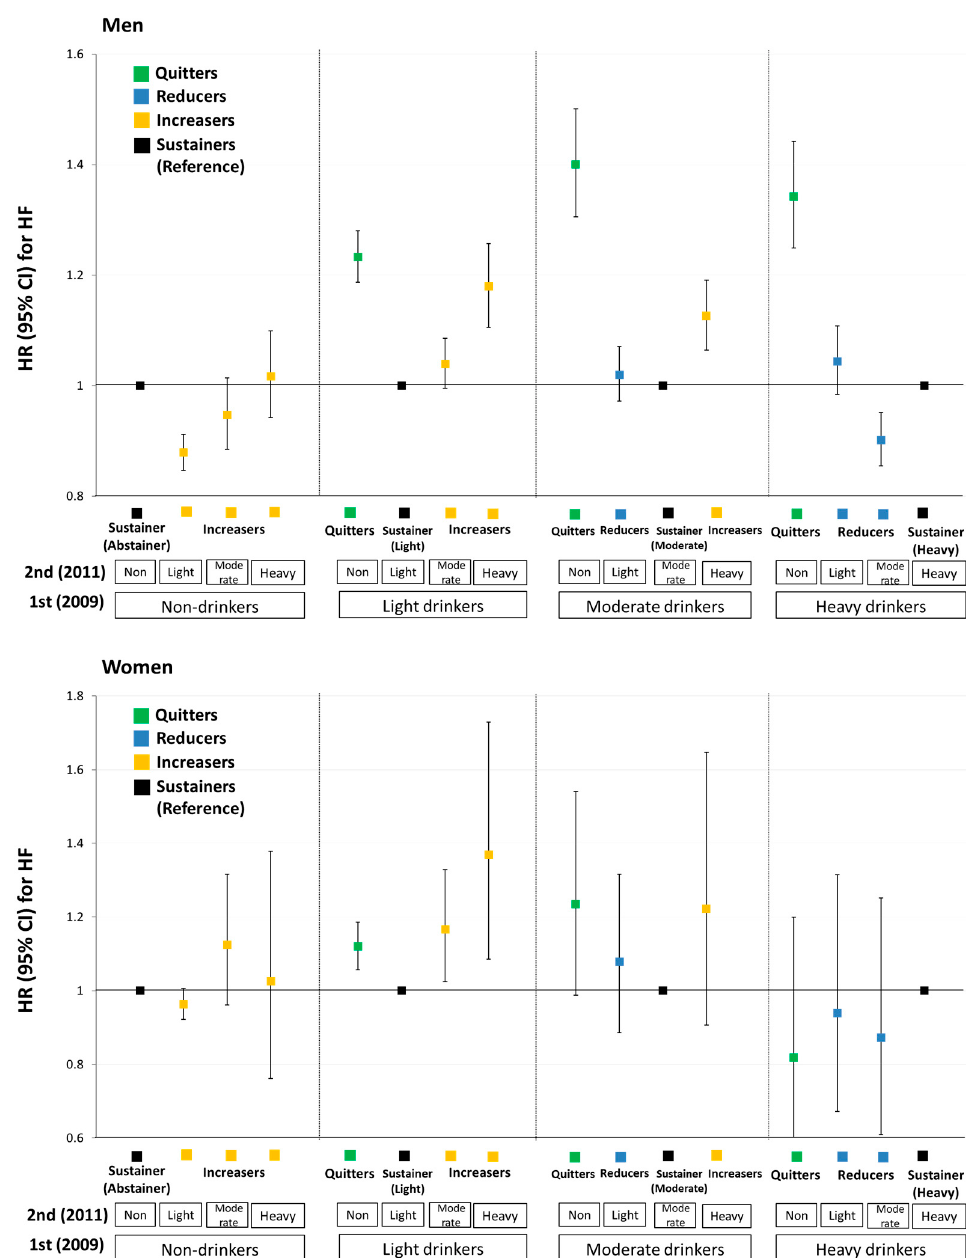
Figure 4. Changes in alcohol consumption amount and risk of congestive heart failure by sex. All HRs were adjusted for age, sex, BMI, smoking status, physical activity, area of residence, income, hypertension, diabetes mellitus, dyslipidemia, systolic blood pressure, fasting glucose level, total cholesterol level, and serum creatinine level. HR, hazard ratio; CI, confidence interval. The initiation of light drinking was associated with lower HF risk in men (aHR =